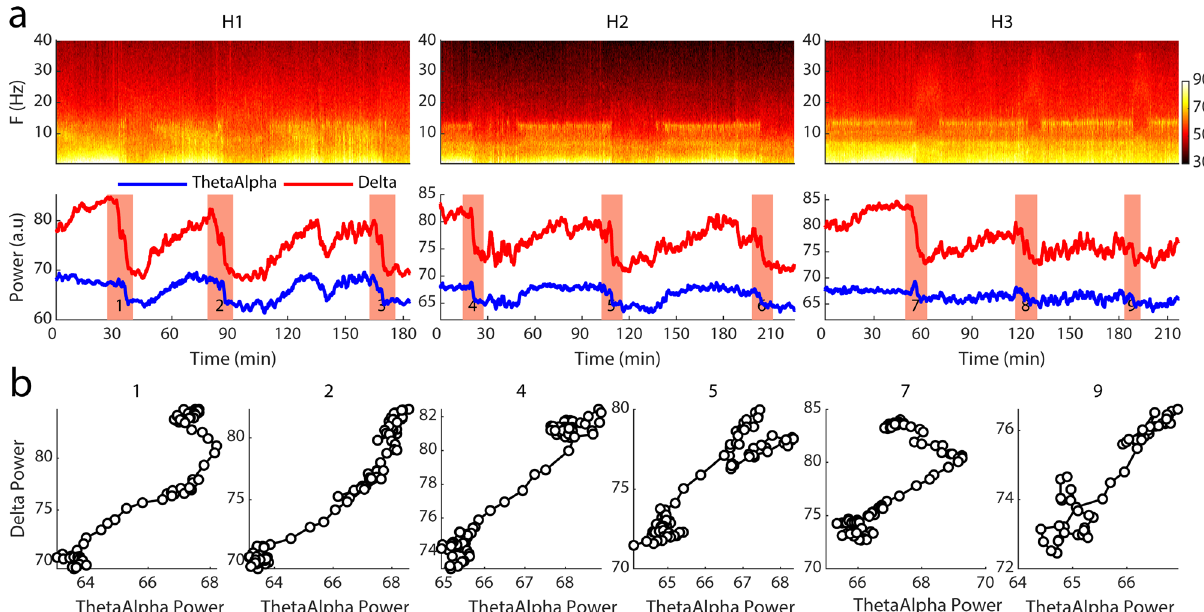
Fig. 2 Example transition episodes in humans. a Top, spectrograms of example episodes of human sleep from three subjects. Bottom panel, corresponding traces of delta (0.5 – 4 Hz) and theta-alpha (4 – 12 Hz) power in red and blue respectively. Red patches highlight transition segments from NREM with high delta power to REM sleep with low delta power. b Delta power vs. theta-alpha power is shown for six example transitions. Title numbers corresponding to transitions with the same numbers from ( a ). Note theta-alpha power increases over the time course of a few transitions (see transition 1 and 7) in comparison to other transitions in which a simultaneous decrease of delta and theta-alpha power is observable. Color bars re fl ect Fourier power in arbitrary